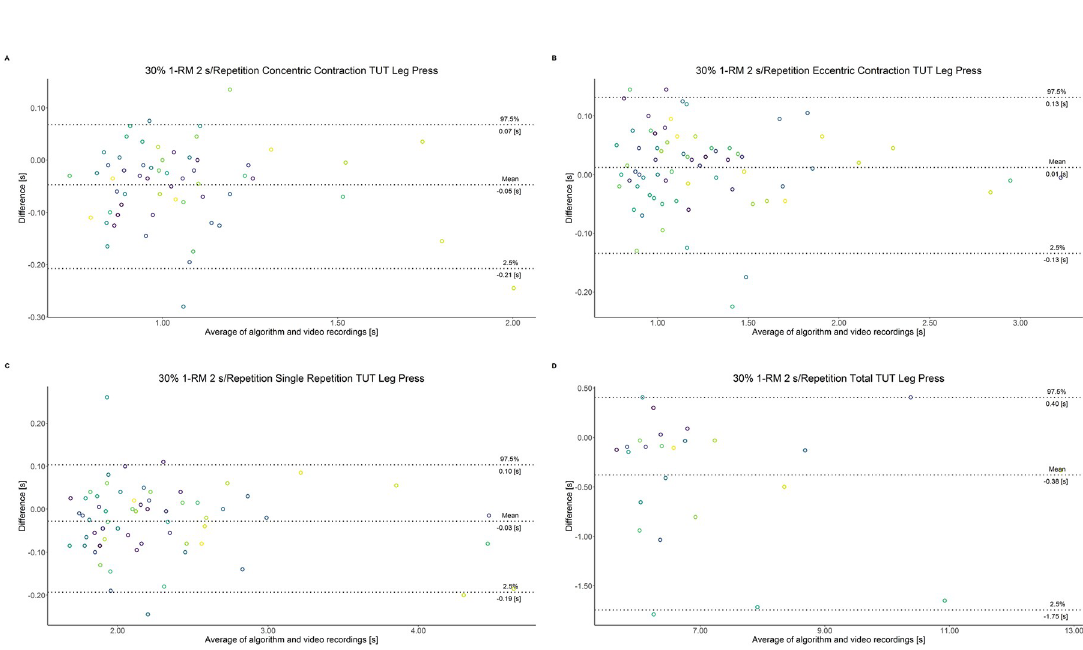
Fig 8. Bland-Altman plots of agreement between algorithmically accelerometer derived and video recordings derived contraction- specific phases of the leg press machine at 30% 1-RM with a velocity of 2 s per repetition. A: Concentric contraction phase. B: Eccentric contraction phase. C: Single repetition. D: Total